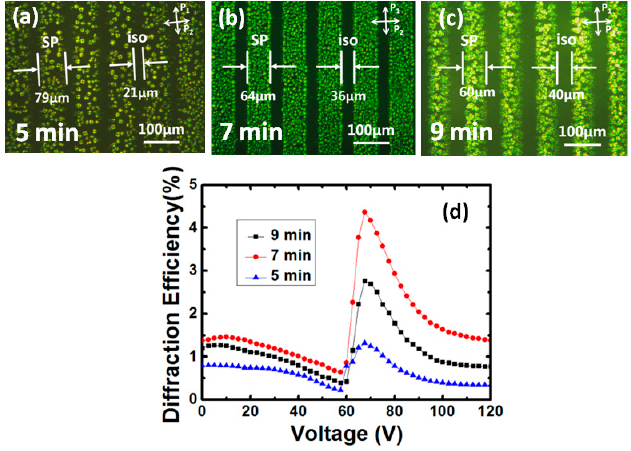
Figure 6. Monomer diffusion effect on the properties of the LC grating. ( a – c ) The polarizing micrographs of PS-SPLC grating with different diffusion time and ( d ) the diffraction efficiency on first order with different diffusion time.